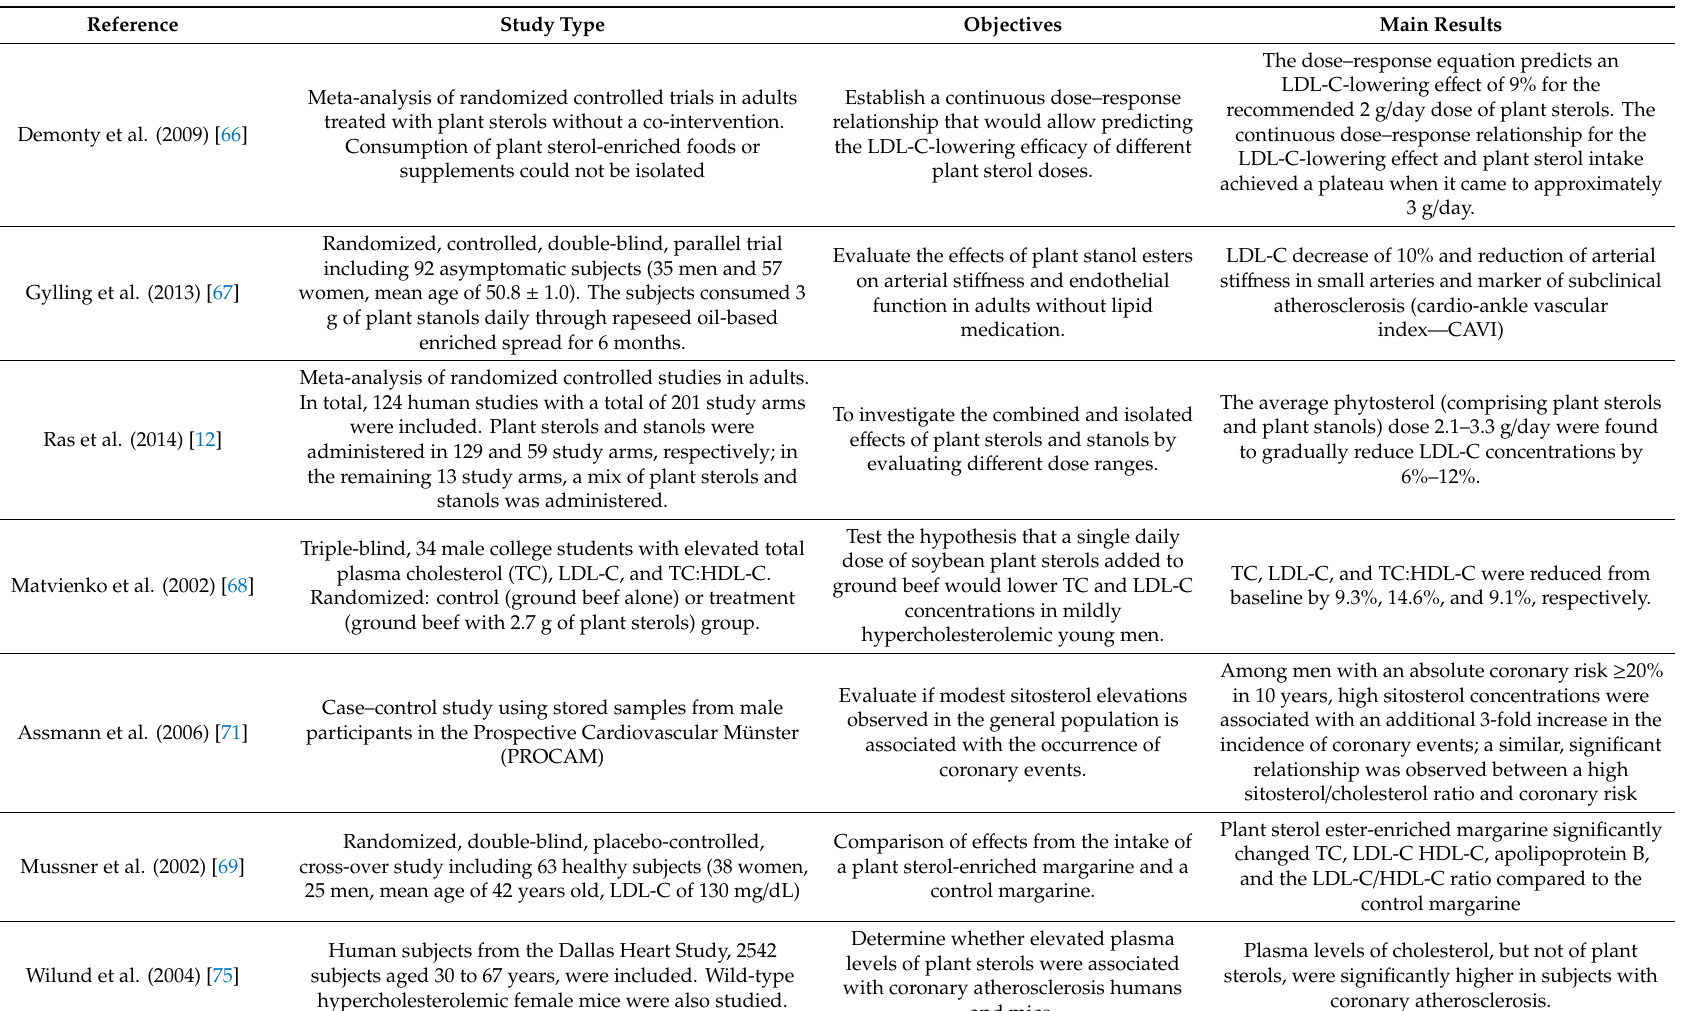
Table 1. Summary of